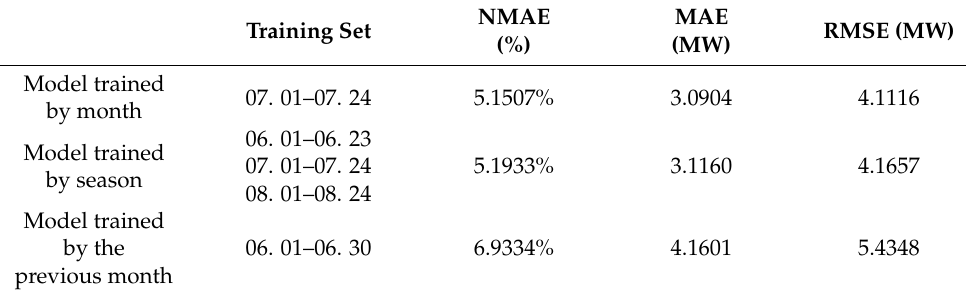
Table 6. Performance evaluation of the GBM